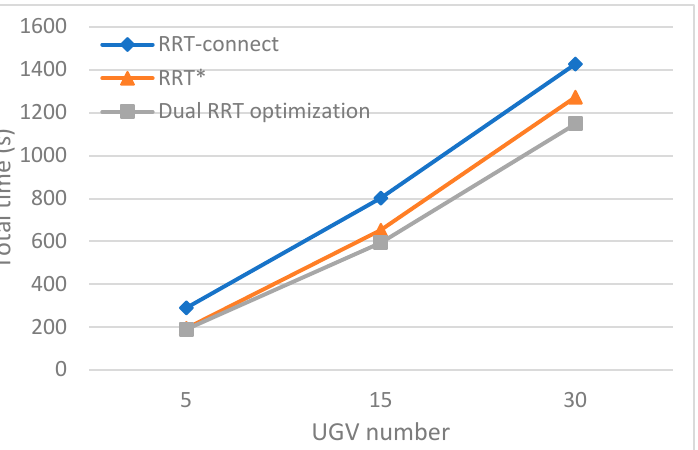
Figure 13. Overall formation time for each algorithm with different numbers of vehicles.